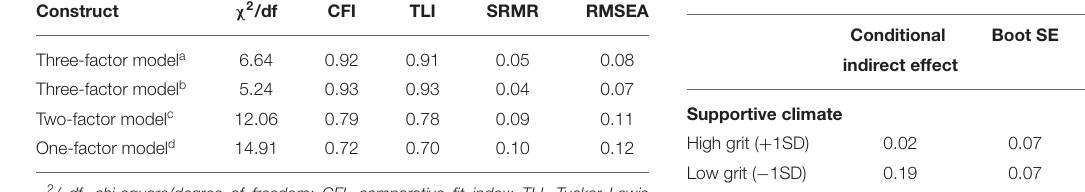
TABLE 4 | Conditional indirect effects.